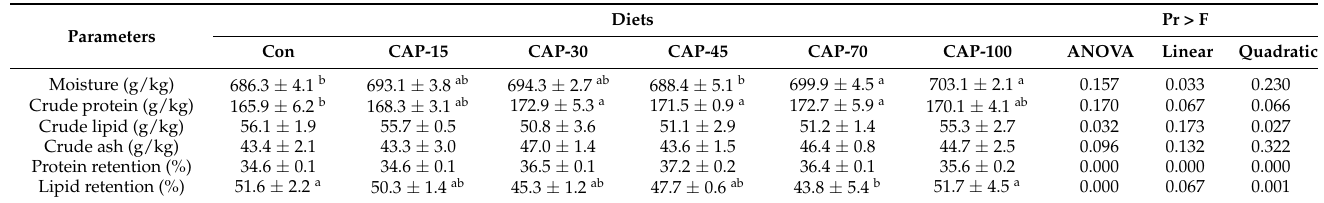
Table 5. Effects of dietary Clostridium autoethanogenum protein on proximate composition of whole body (fresh weight) and nutrients retention of largemouth bass.